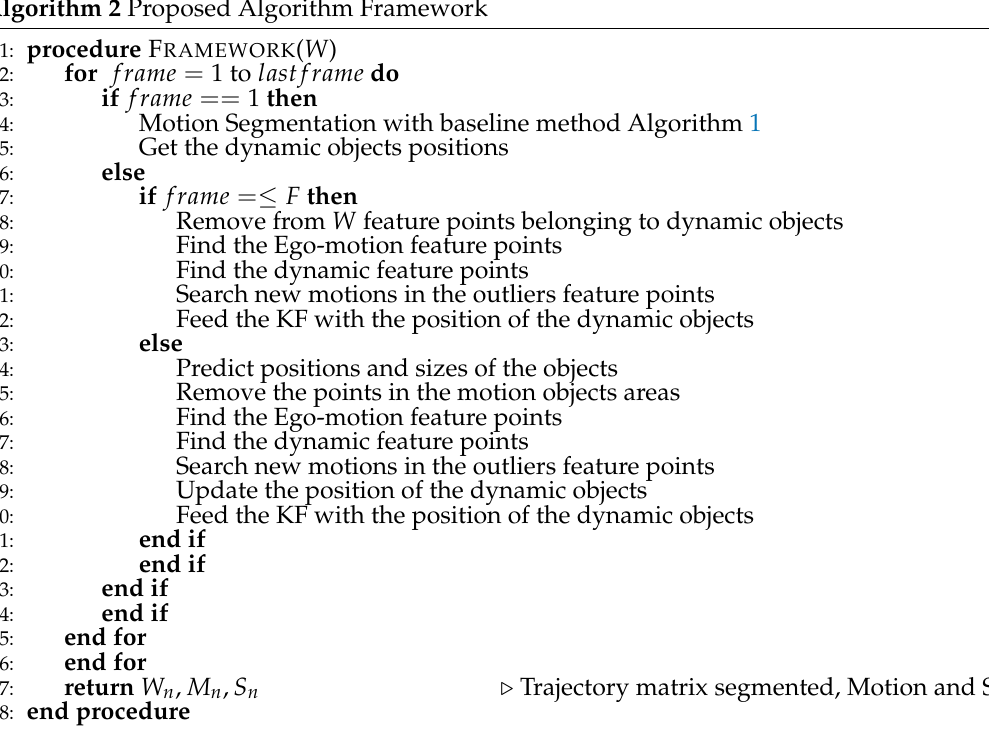
Algorithm 2 Proposed Algorithm